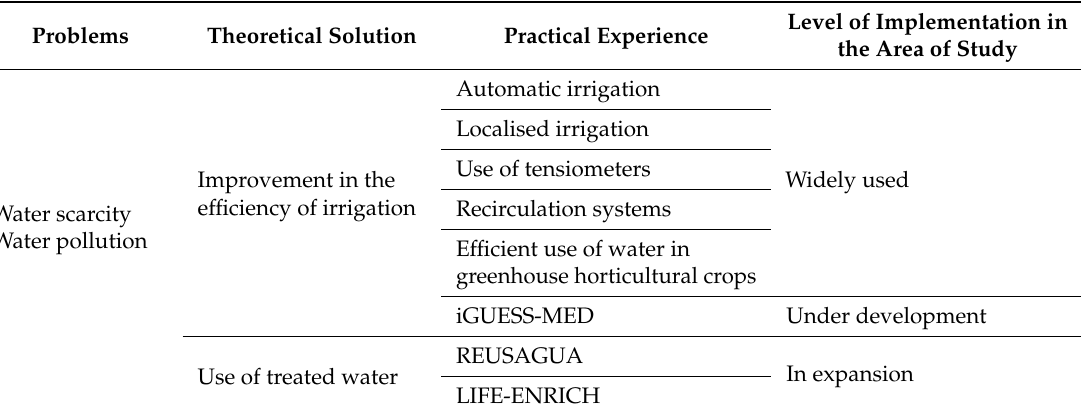
Table 5. Main solutions based on the CE for water